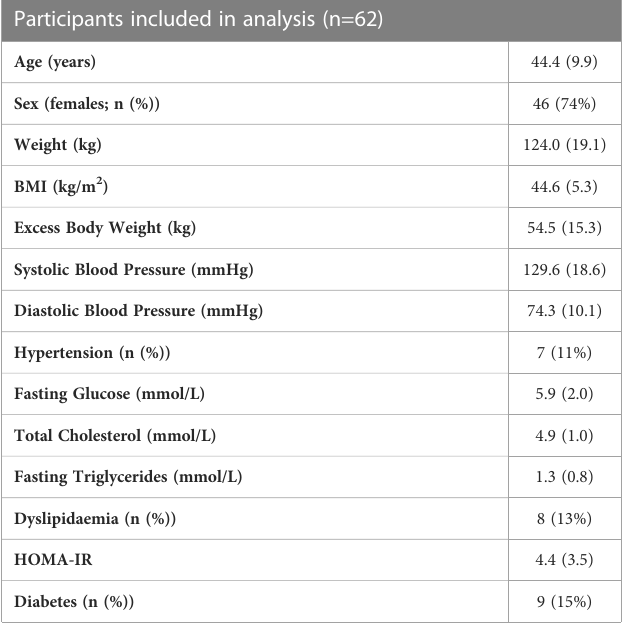
Values are mean (standard deviation) unless otherwise stated. BMI, bodymass index,HOMA- IR, homeostatic model assessment of insulin